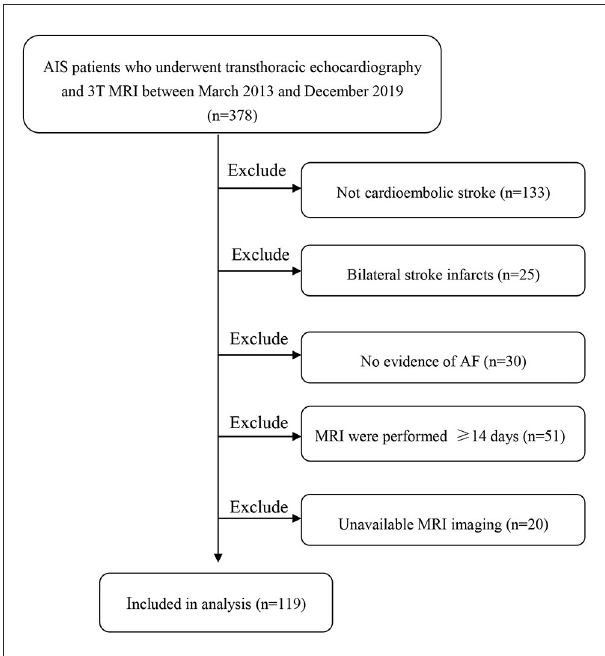
FIGURE1 Study flowchart. AF, Atrial fibrillation; AIS, acute ischemic stroke.